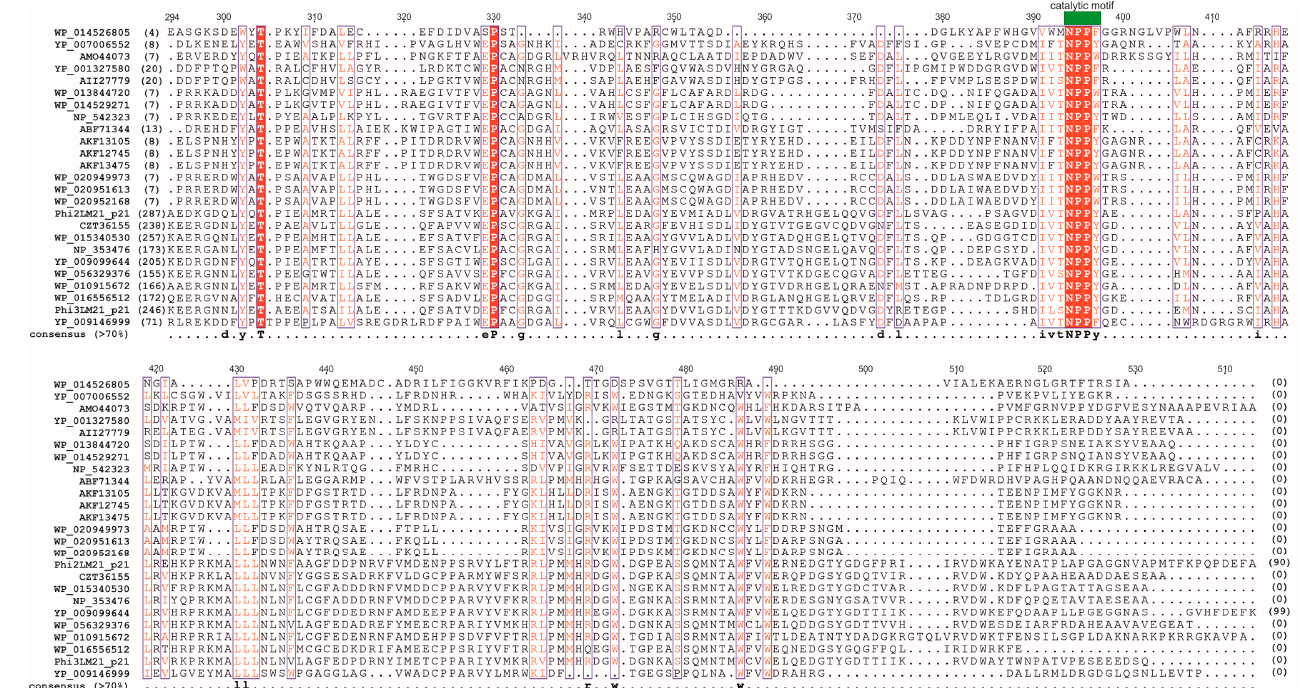
Figure 3. Alignment of the putative and experimentally confirmed CcrM-like specific DNA methyltransferases (MTases) found within the phages and predicted prophage regions of Alphaproteobacteria . The MTases with the following NCBI accession numbers were used for the alignment: AKF13105 (of Φ M19); AKF12745 (of Φ M7); AKF13475 (of Φ N3); YP_007006552 (of Agrobacterium phage 7-7-1); AMO44073 (of Roseobacter phage DSS3P8); YP_001327580 (of Φ 3_WSM419);